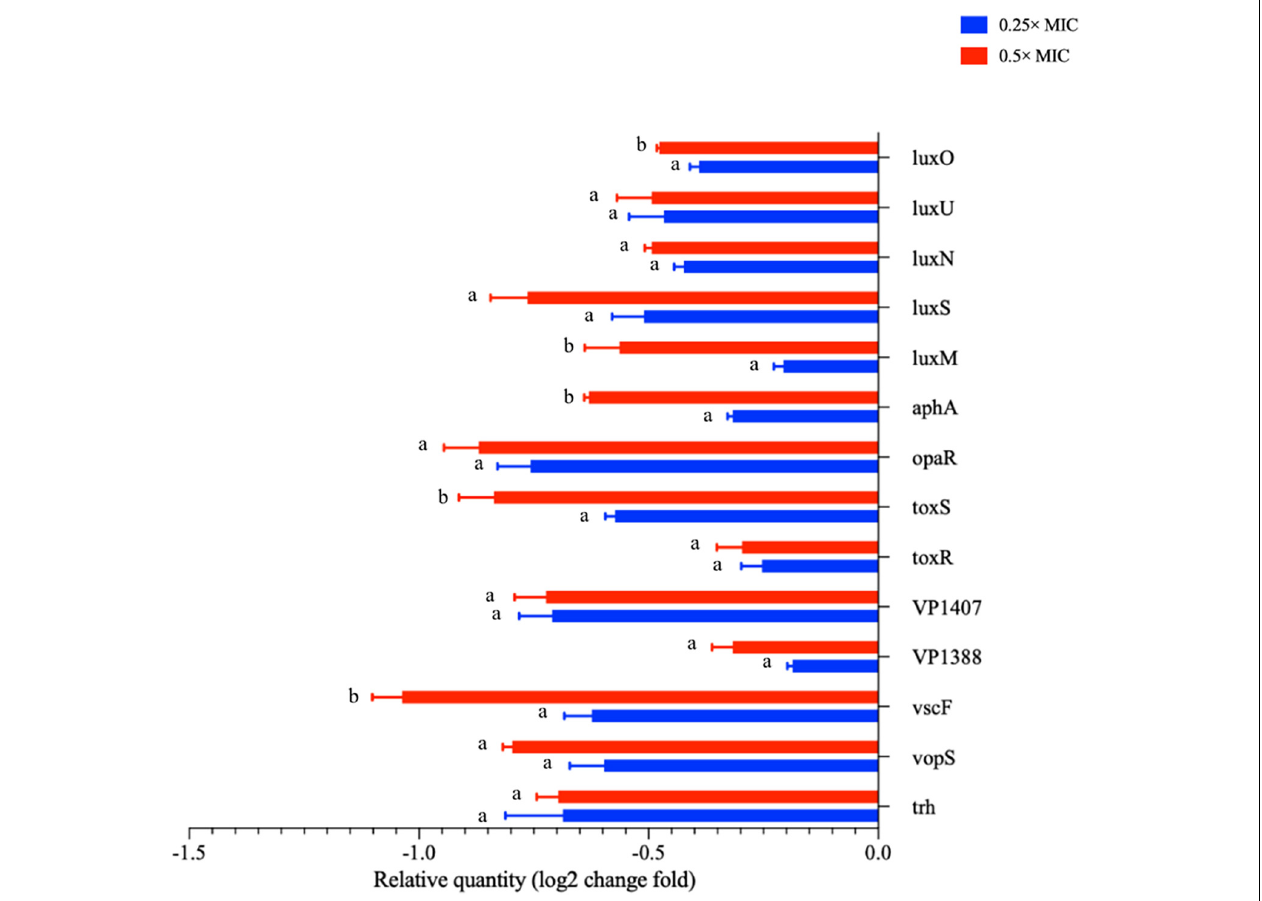
FIGURE 5 | The transcription levels of virulence related genes of V. parahaemolyticus treated with Melissa officinalis L. essential oil. CK is the V. parahaemolyticus without Melissa officinalis L. essential oil